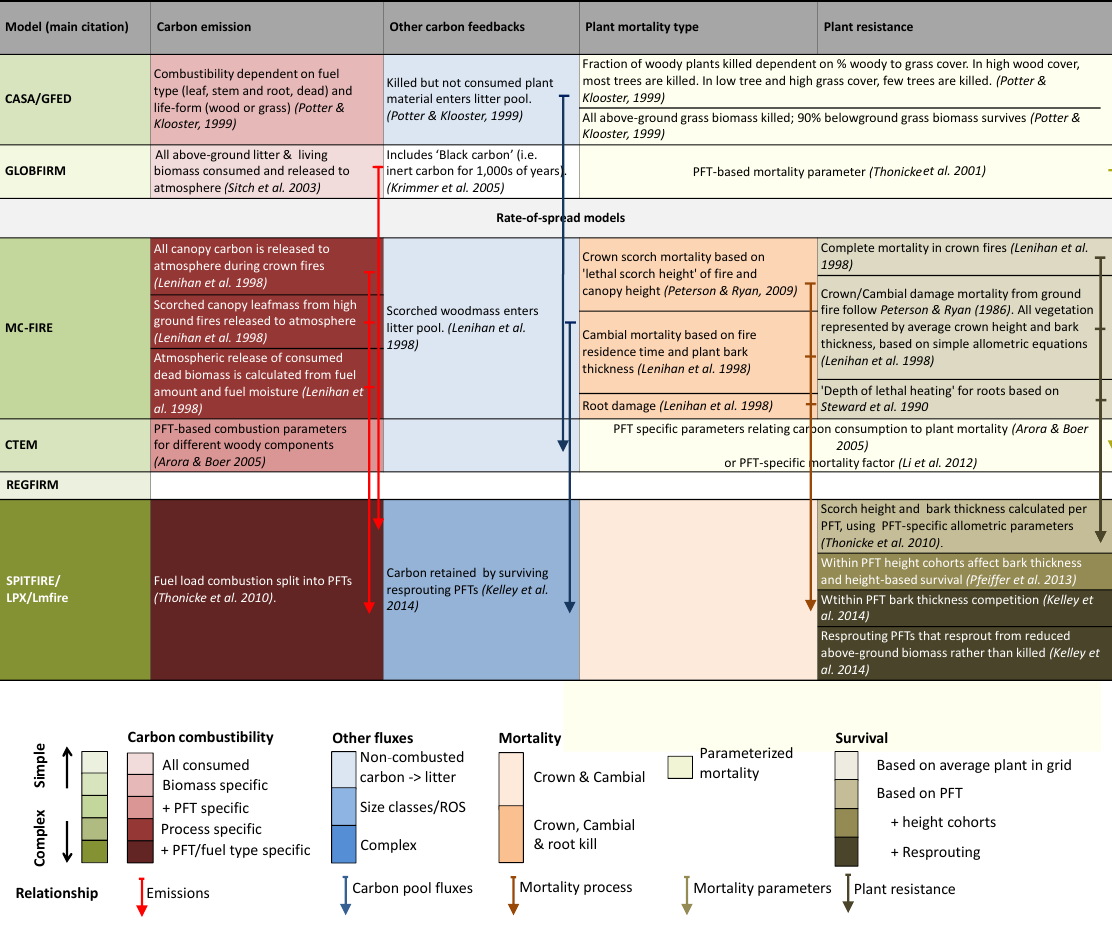
Table 2. Representation of the impacts of fire in fire-enabled DGVMs. Intensity of colour indicates the complexity of the description of the component. Green indicates complexity of the representation of fire impacts. Red describes the complexity of the description of atmospheric fluxes from fire: flux is equivalent to all consumed biomass (light red); consumption based on biomass-specific combustion parameters; inclusion of PFT combustion parameters; process-based; and biomass/PFT parameterized process-based (dark red). Blue represents the complexity of carbon fluxes to other carbon pools: no additional fluxes (white); non-combusted dead carbon flux (light blue); carbon fluxes based on fire spread properties; and fire-adapted vegetation carbon retention (dark blue). Orange represents complexity of simulated mortality processes: parameterized morality (yellow); mortality from crown and cambial damage (light orange); and additional root damage mortality (dark orange). Brown represents complexity of plant adaptation to fire when mortality processes are included: mortality based on a grid cell’s “average plant” properties of fire-resistant traits (light brown); PFT-based average traits; inclusion and height cohorts; and inclusion of dynamic/complex adaptations such as resprouting (RS) (dark brown). Arrows demonstrate the exchange of components between models, starting in the model containing the original